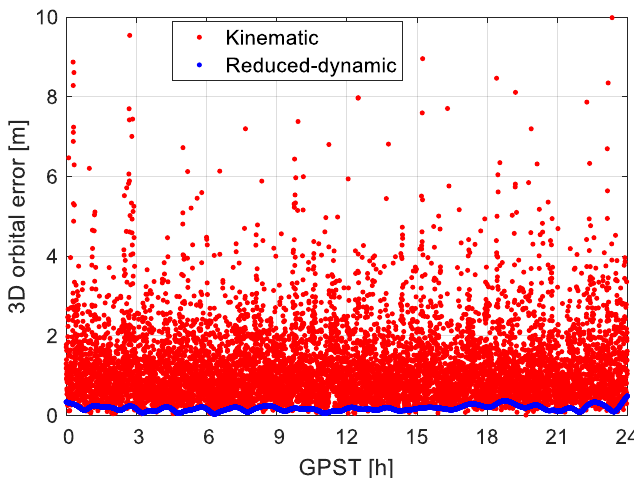
Figure 3. 3D orbital errors of the code-based kinematic (red) and reduced-dynamic daily arc (blue) with a sampling interval of 10 s. The IGS final products were used for the GPS satellites.